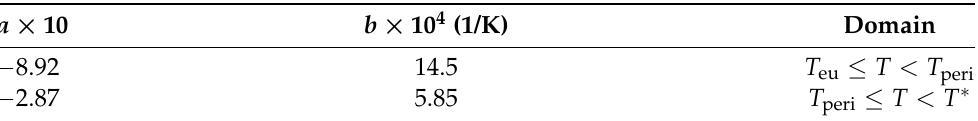
Table 4. Coefficients of fits to the liquidus curve of Ellinger [7]. Fits were of the form x = a + bT , for x defined in Equation